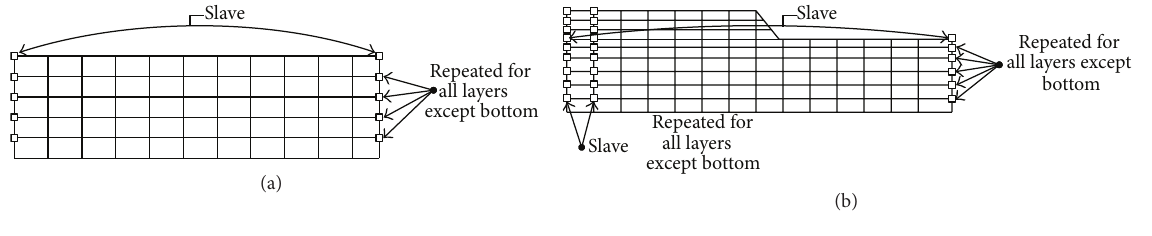
Figure 4: Representation of